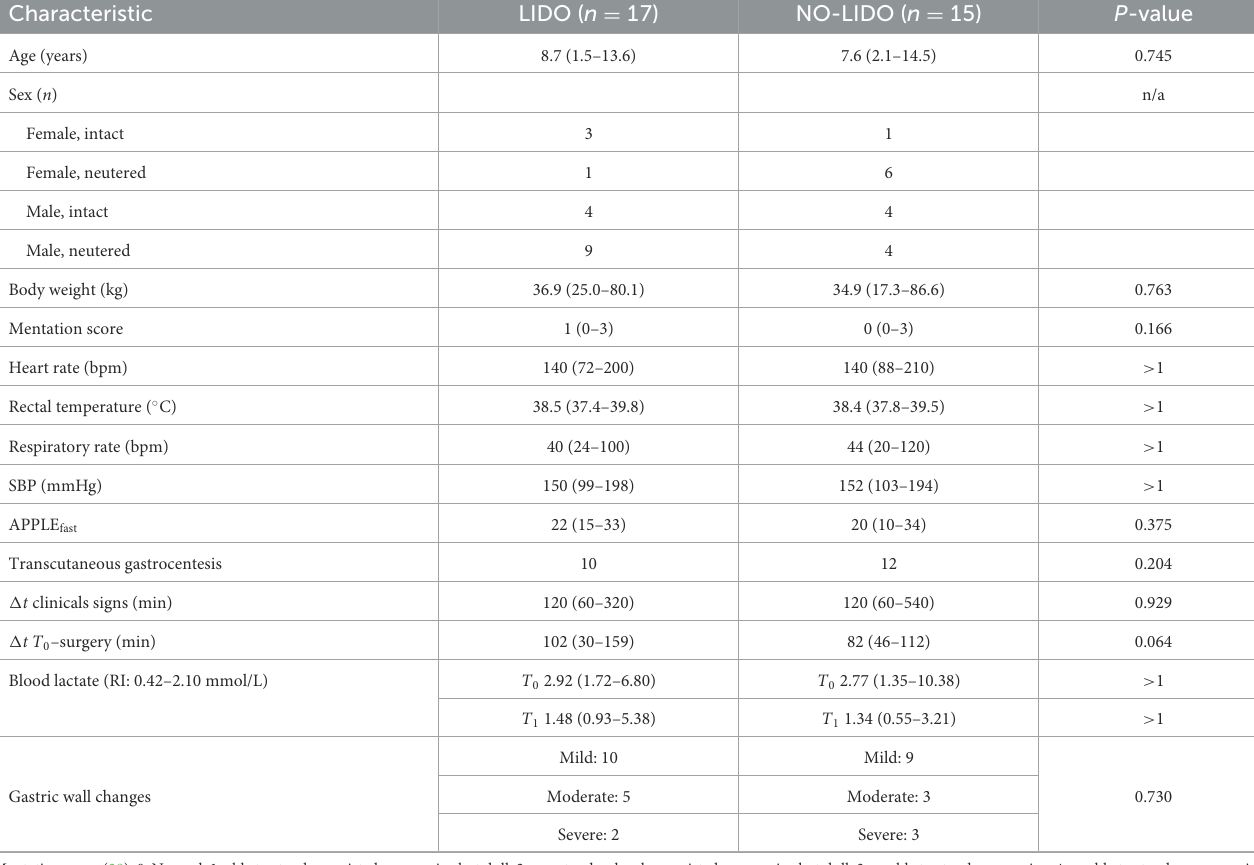
TABLE 2 Demographic and clinical baseline data (median, min–max) in 32 dogs randomized to the LIDO or NO LIDO group.